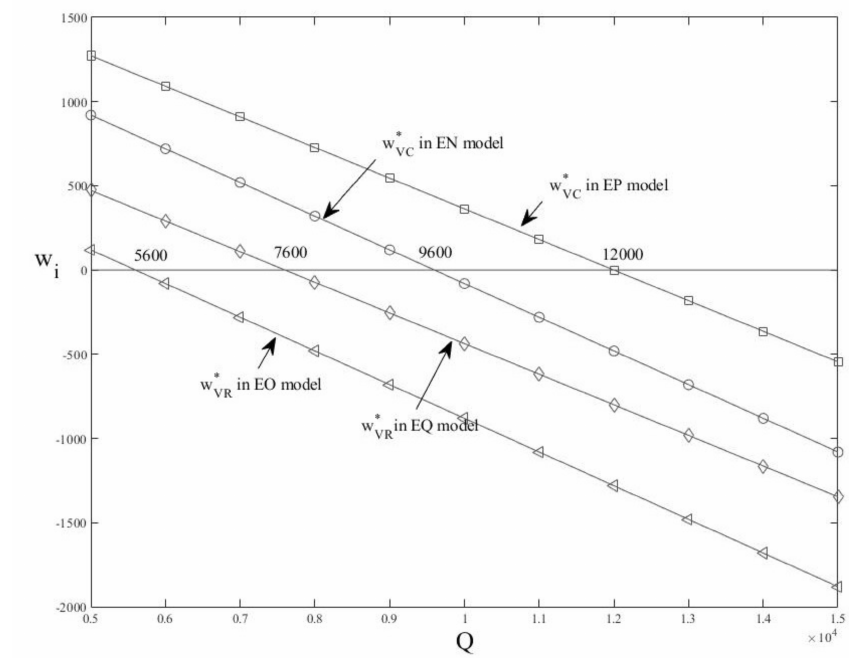
Figure 3. The impact of Q on w i